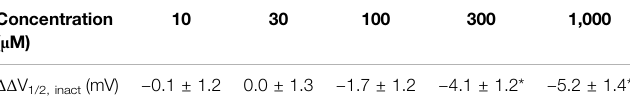
TABLE 1 | Effect of oseltamivir on the steady-state inactivation curve of Na V 1.5. Concentration 10 30 100 300 1,000 ( μ M)